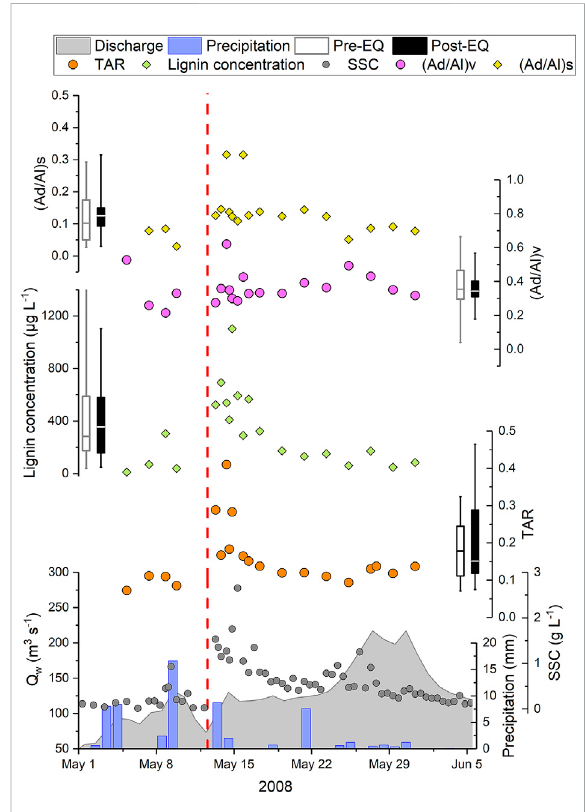
FIGURE 6 ThePOCsourceandhydrologyinMay2008,beforeandafter the earthquake. The open and fi lled boxes show the mean values before and after the earthquake with 25% and 75% percentile, while whiskers indicate the 5% and 95% percentile of each proxy. The red dash line represents the occurrence time of 2008 Wenchuan